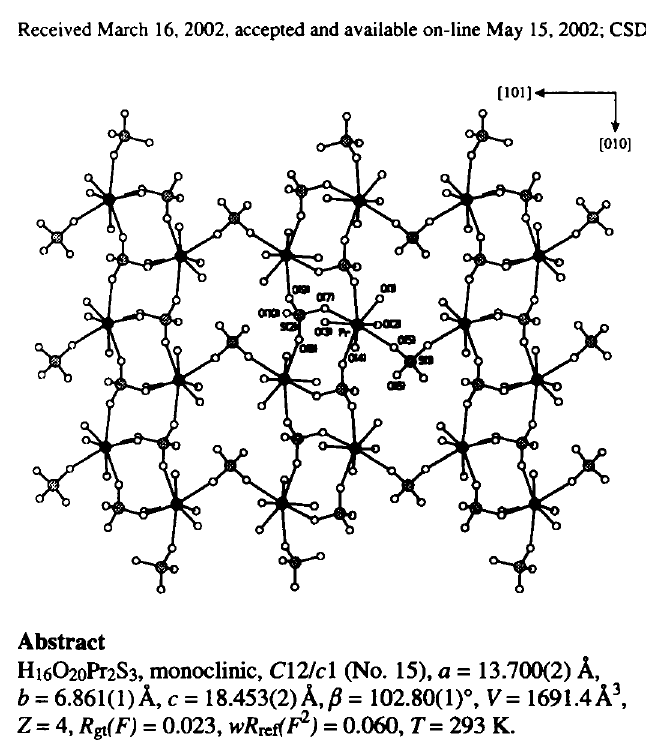
Table 2. Atomic coordinates and displacement parameters (in Â 2